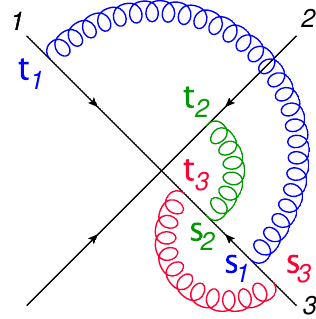
Figure 21 . Diagram ( a ) of the (1,1,4) web of figure 7. The parameters indicating the position of each gluon emission and absorption along the lines are indicated by s